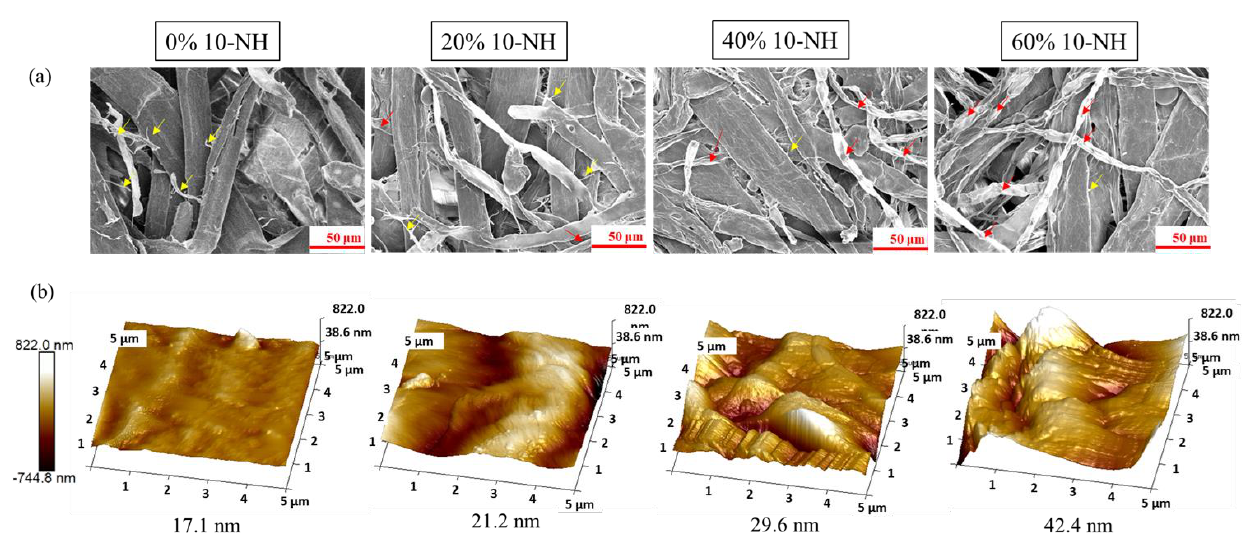
Figure 9. ( a ) SEM and ( b ) AFM images with average roughness values for 0%, 20%, 40%, and 60% 10-NH mixed pulp handsheets (red arrow: 10-NH algal fiber; yellow arrow: microfibrils of wood fiber).